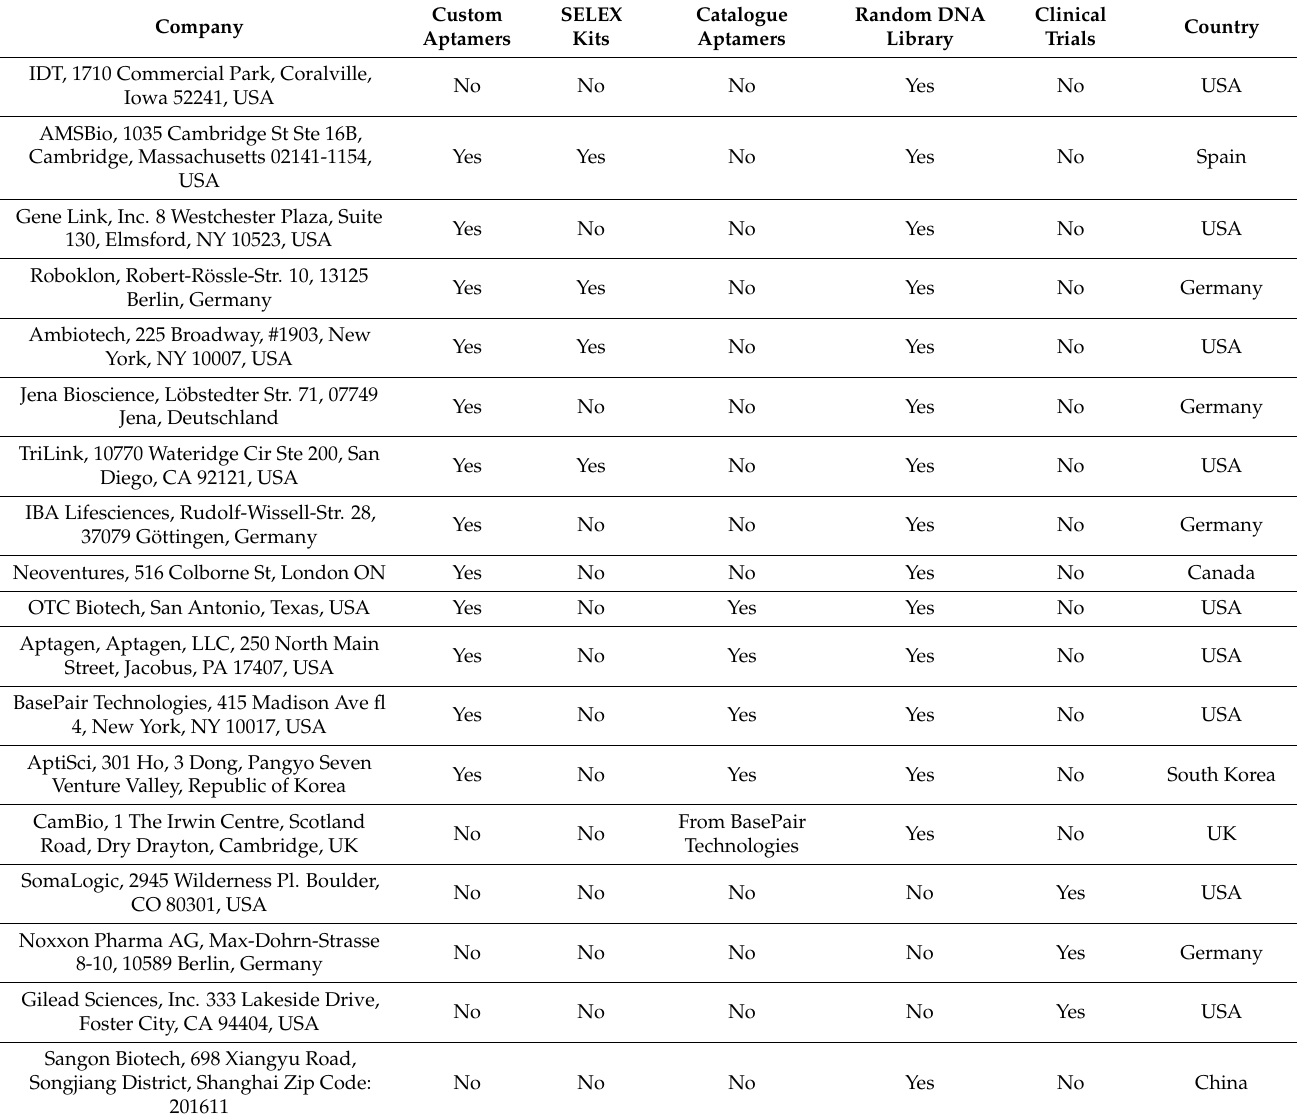
Table A5. List of companies offering various aptamer-based services. All the data presented here has been collected from the respective company websites.